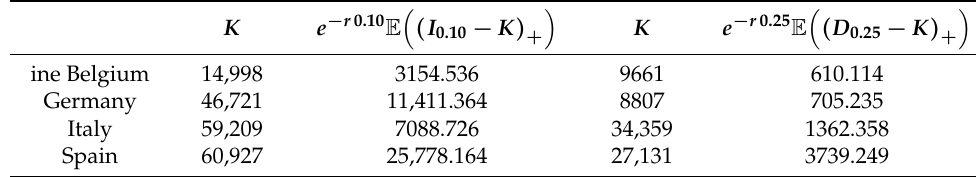
Table 12. Prices of excess of loss reinsurance treaties. r =